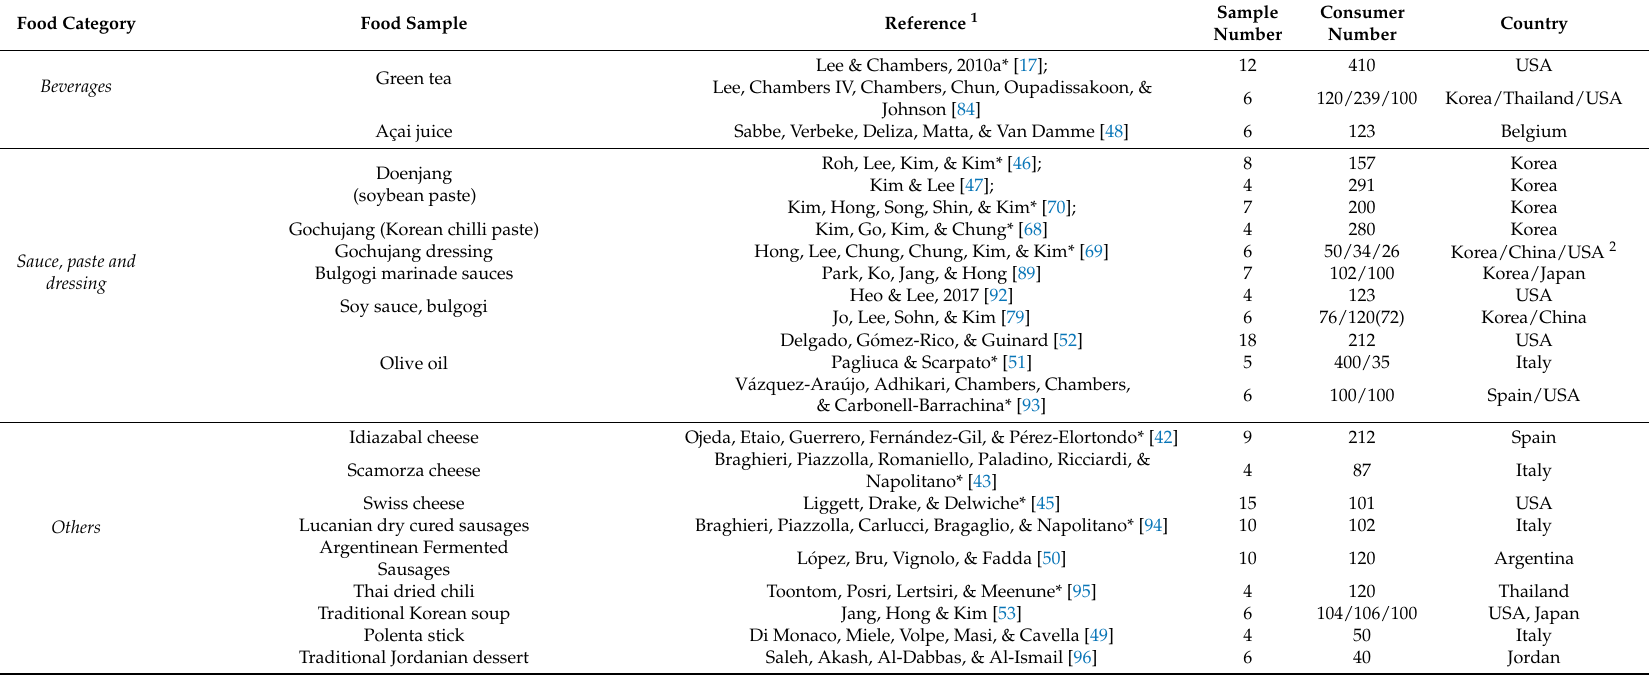
Table 2. Consumer acceptability studies using traditional foods as